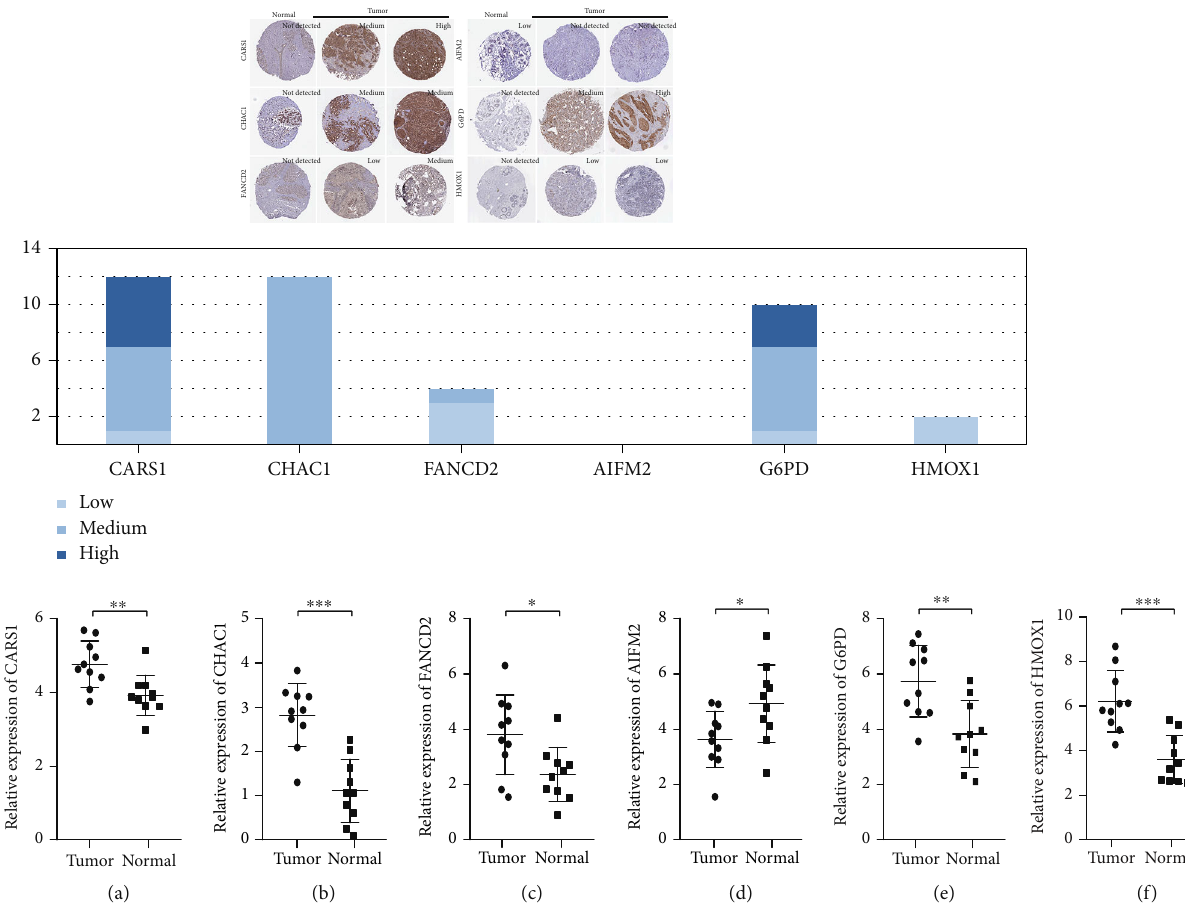
Figure 6: Expression levels of CARS1, CHAC1, FANCD2, AIFM2, G6PD, and HMOX1 in breast cancer and normal breast tissues validated in the Human Protein Atlas. The bar graph shows the cases with di ff erent expression levels of the six genes in breast cancer tissues. Light blue indicates low expression level; dark blue, low expression level; and shade between the two colors, medium expression level. The longitudinal axis shows the number of cases, and the transverse axis represents di ff erent genes. (a – e) Validation of the expression levels of the six genes between the normal breast samples ( n = 10 ) and breast cancer samples ( n = 10 ) by polymerase chain reaction analysis. All the data are presented as mean ± SD . Signi fi cant di ff erences are de fi ned by ∗ p < 0 : 05 , ∗∗ p < 0 : 01 , and ∗∗∗ p < 0 : 001